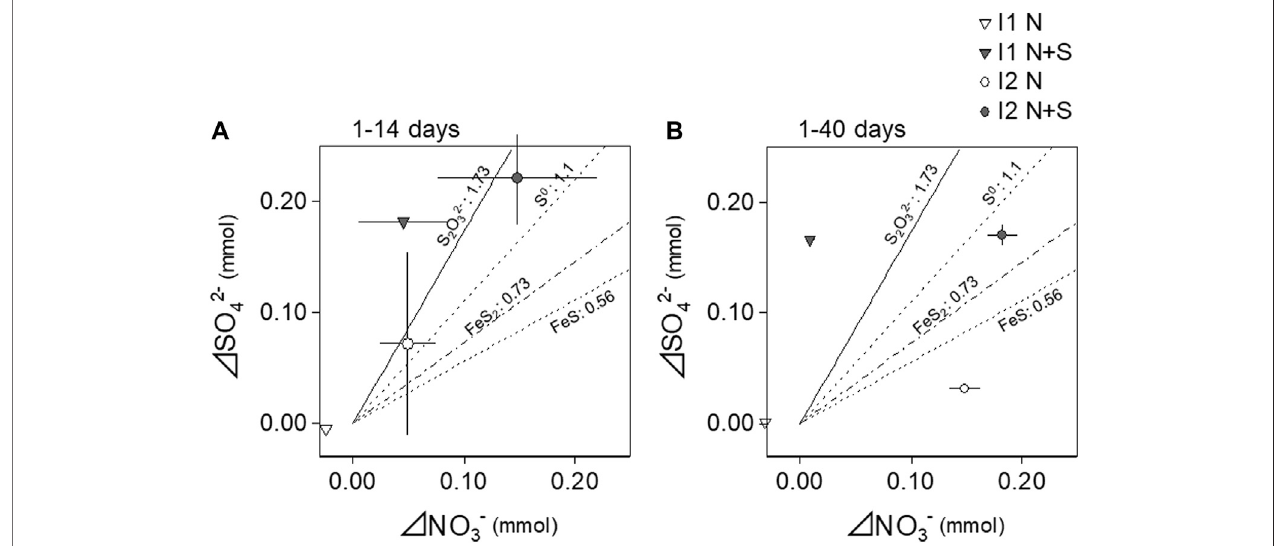
FIGURE 5 | Relationships between nitrate consumption ( Δ NO 3 − ) and sulfate production ( Δ SO 42 − ) during long-term incubation. The estimation period for the consumption or the production values from days 1 – 14 (A) and from days 1 – 40 (B) . Lines in the fi gure indicate stoichiometric S/N of sulfur-based denitri fi cation using different electron donors of S. S 2 O 32 − , Matsui and Yamamoto (1986); S 0 , Batchelor and Lawrence (1978); FeS 2 , Tong et al. (2017); FeS, Schippers and Jørgensen (2002).